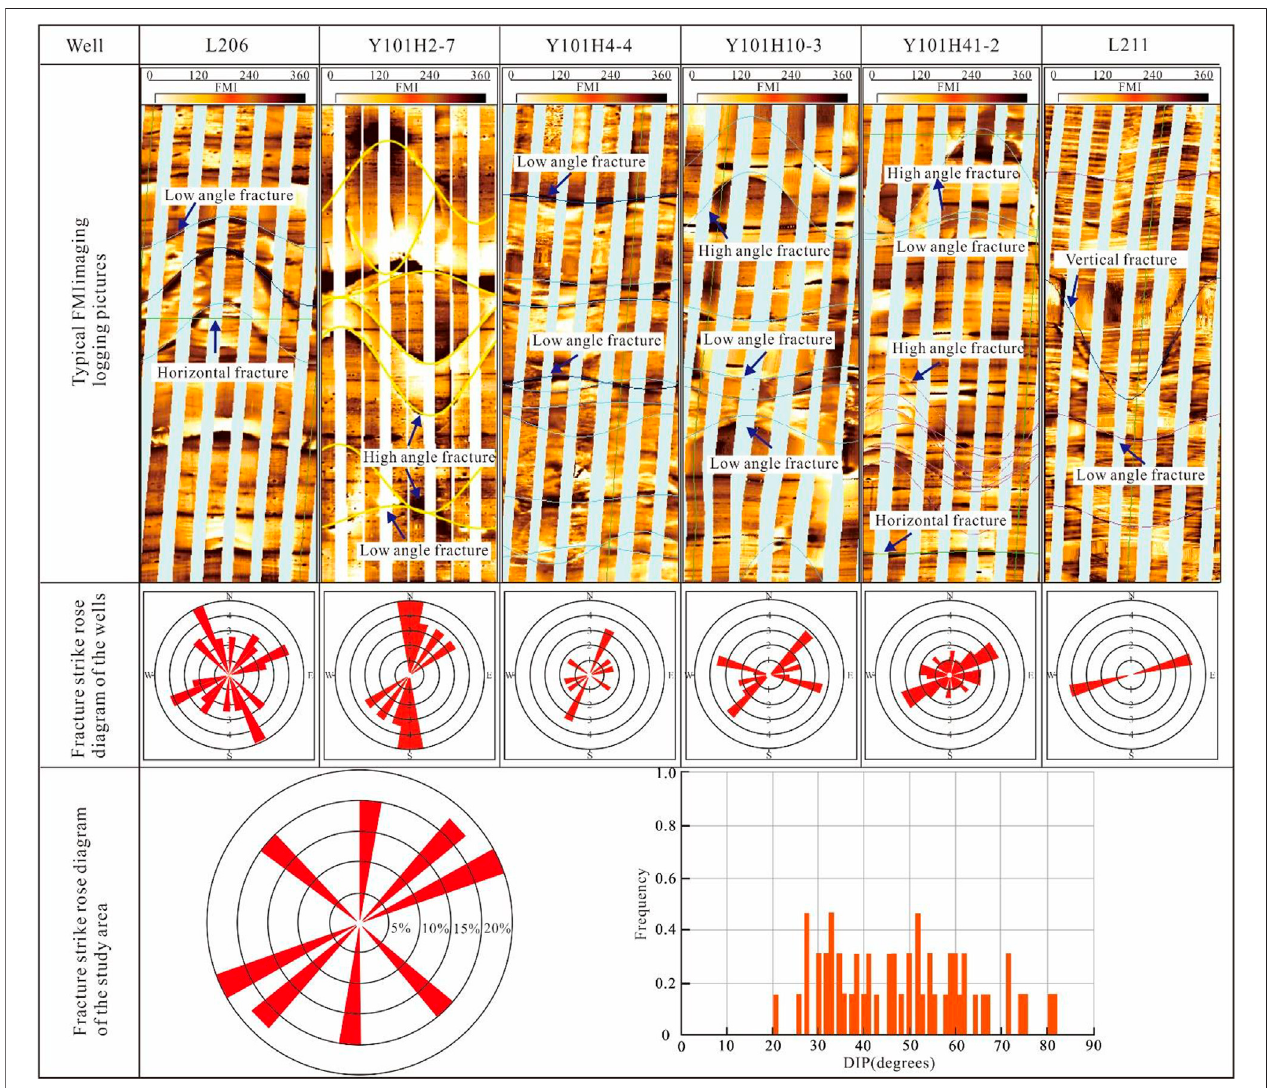
FIGURE 5 | Identi fi cation of fracture occurrence based on imaging